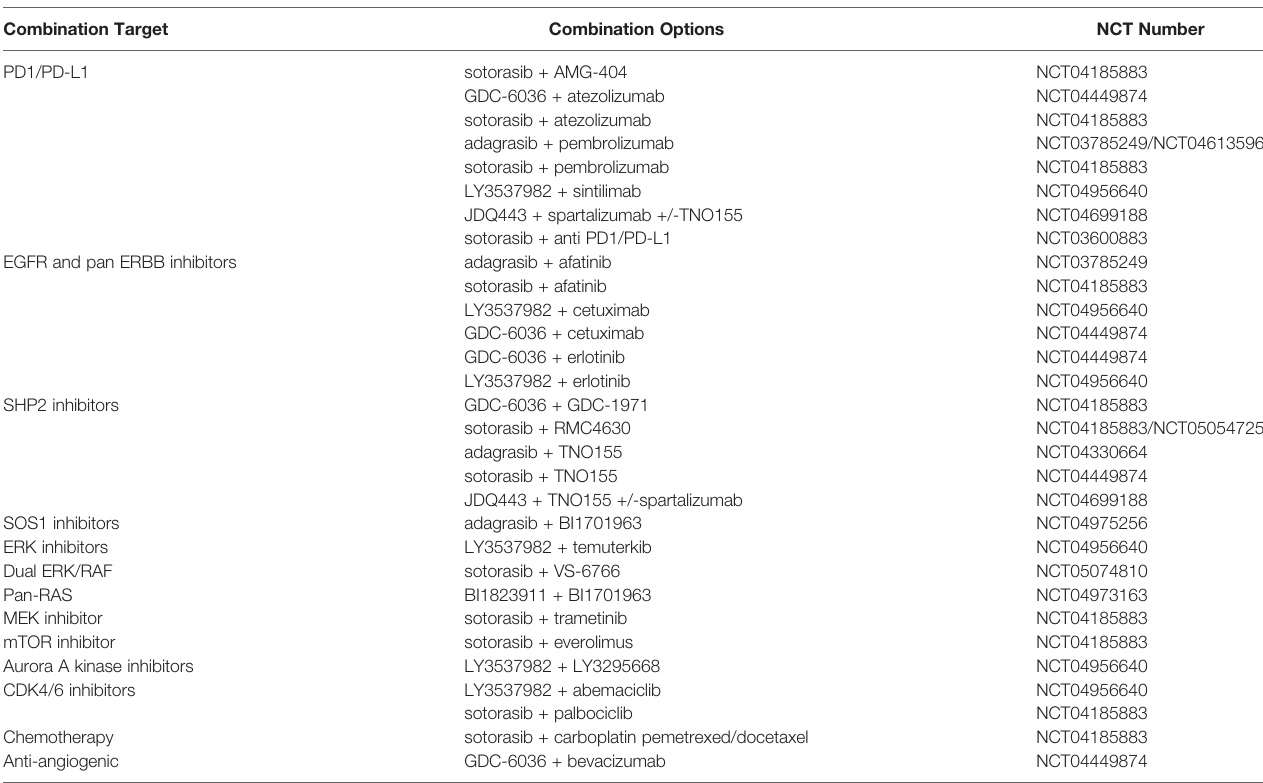
TABLE 3 | Ongoing clinical trials to target mutant